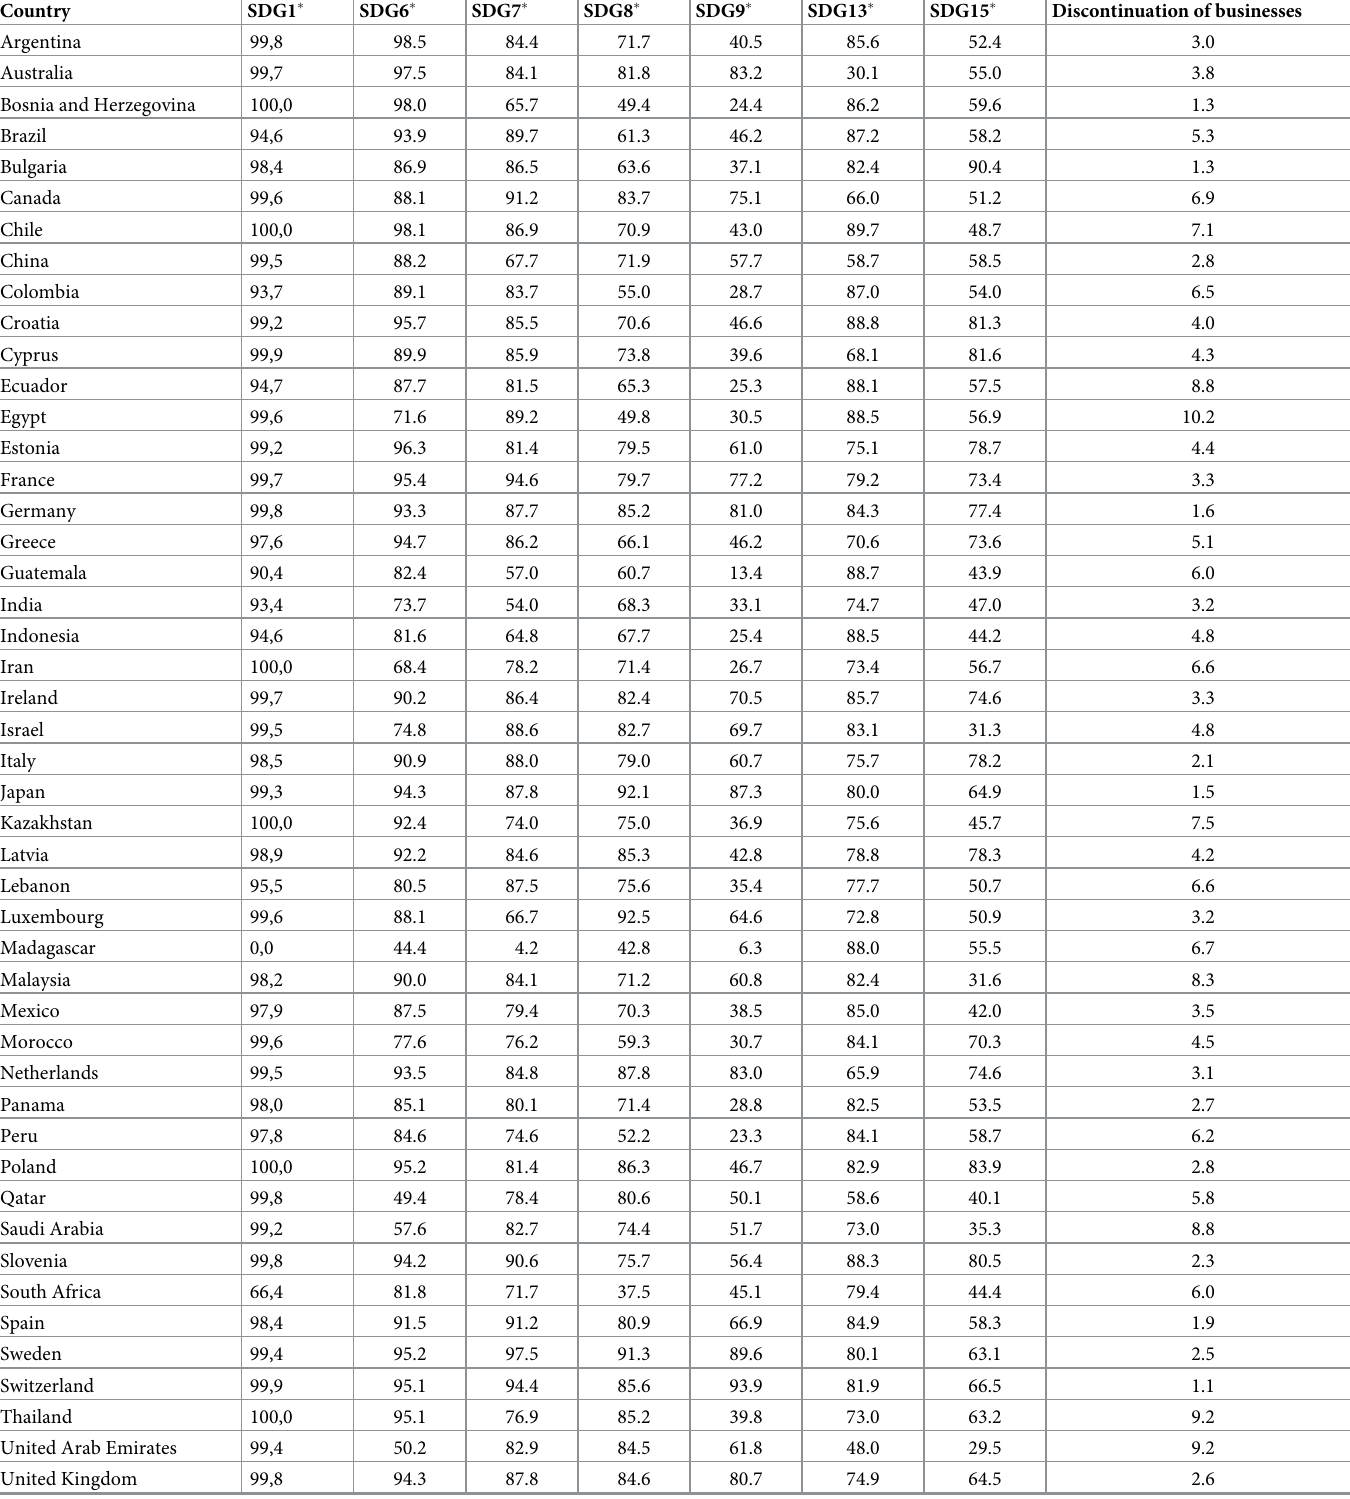
Table 1. Countries’